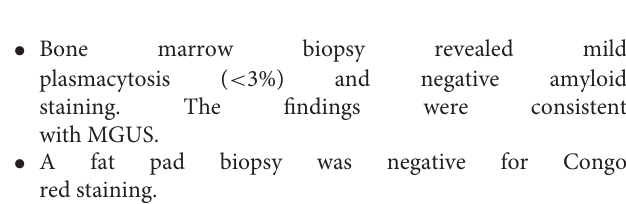
FIGURE 3 | ECG (A) showing sinus rhythm with LVH and a borderline prolonged QT interval. Echocardiogram (B) showing moderate concentric LVH, moderate to severe biatrial enlargement and mild RV enlargement. ECG, electrocardiogram; LVH, left ventricular hypertrophy; RV, right ventricular.